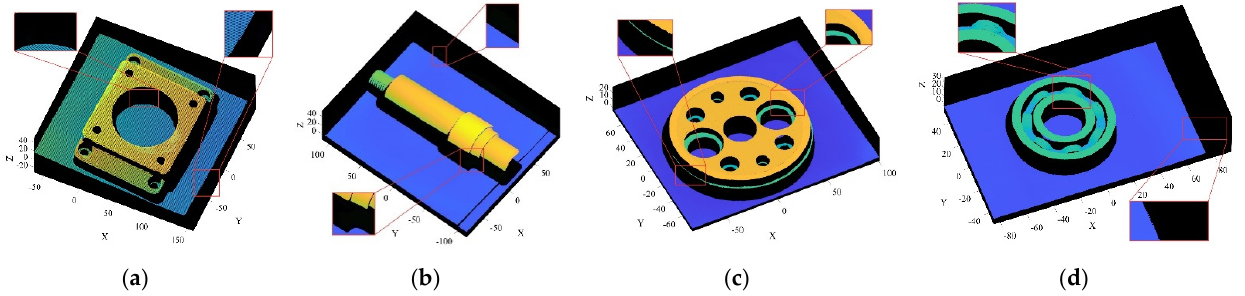
Figure 14. Denoising results for R-SLDM algorithm: ( a ) object 1; ( b ) object 2; ( c ) object 3; ( d ) object 4.